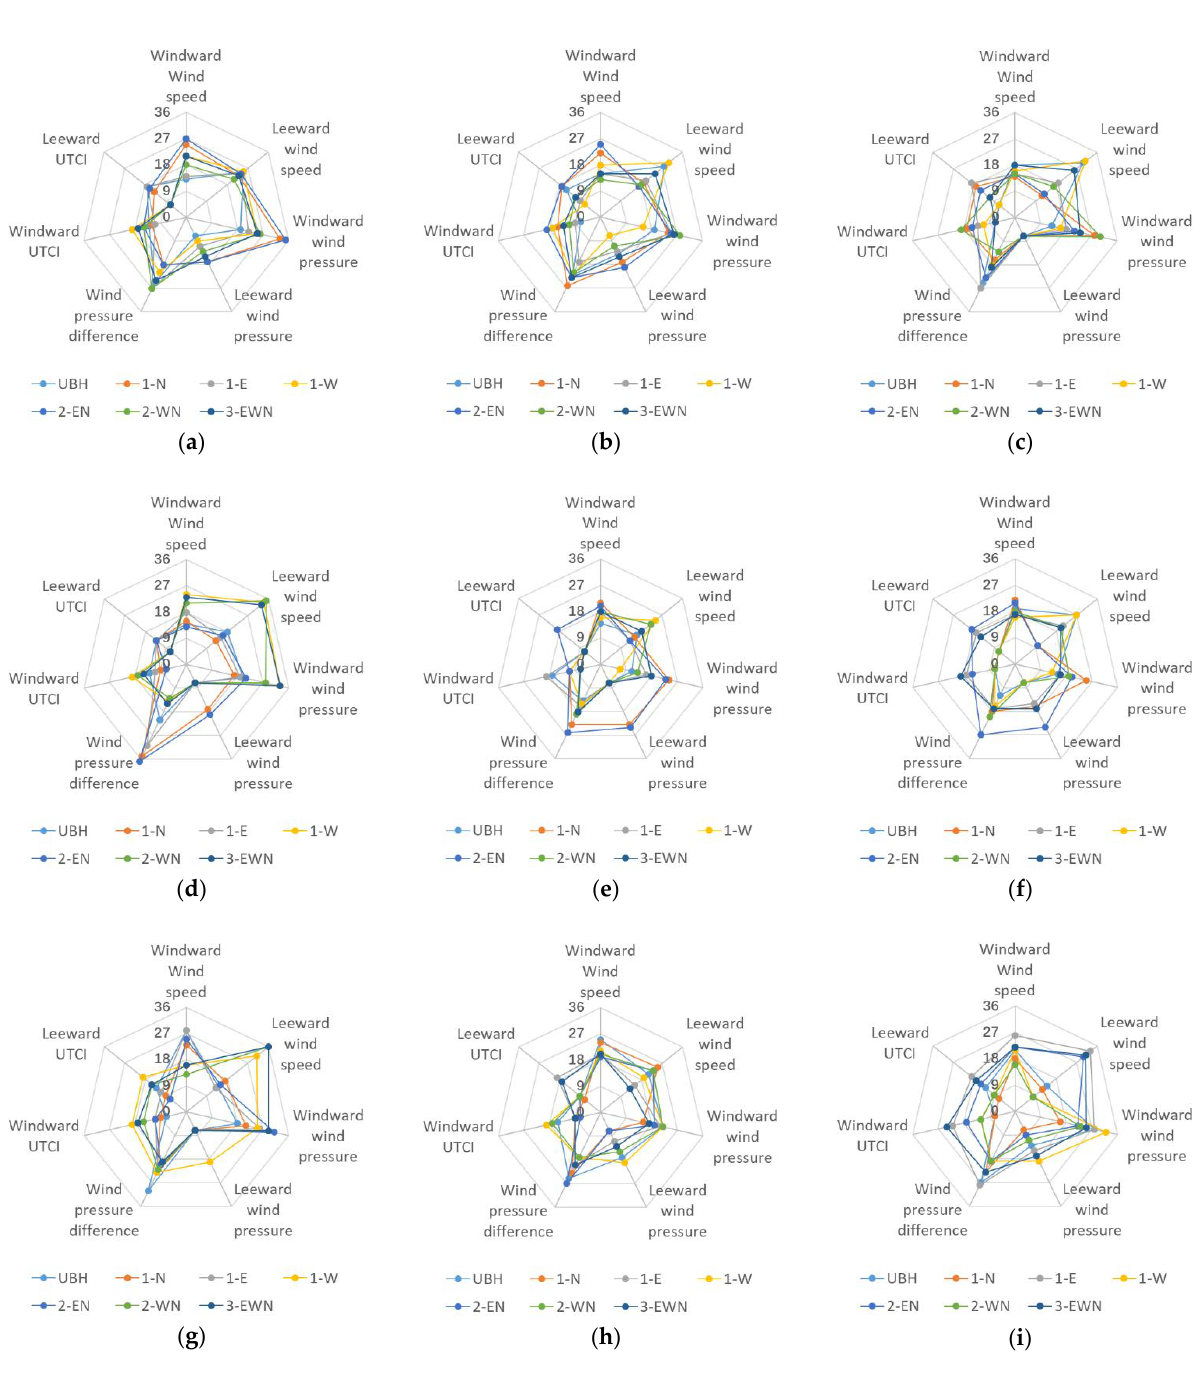
Figure A12. Results summary of single building wind environment parameters and UTCI under seven layouts; ( a ) building #1, ( b ) building #2, ( c ) building #3, ( d ) building #4, ( e ) building #5, ( f ) building #6, ( g ) building #7, ( h ) building #8, and ( i ) building